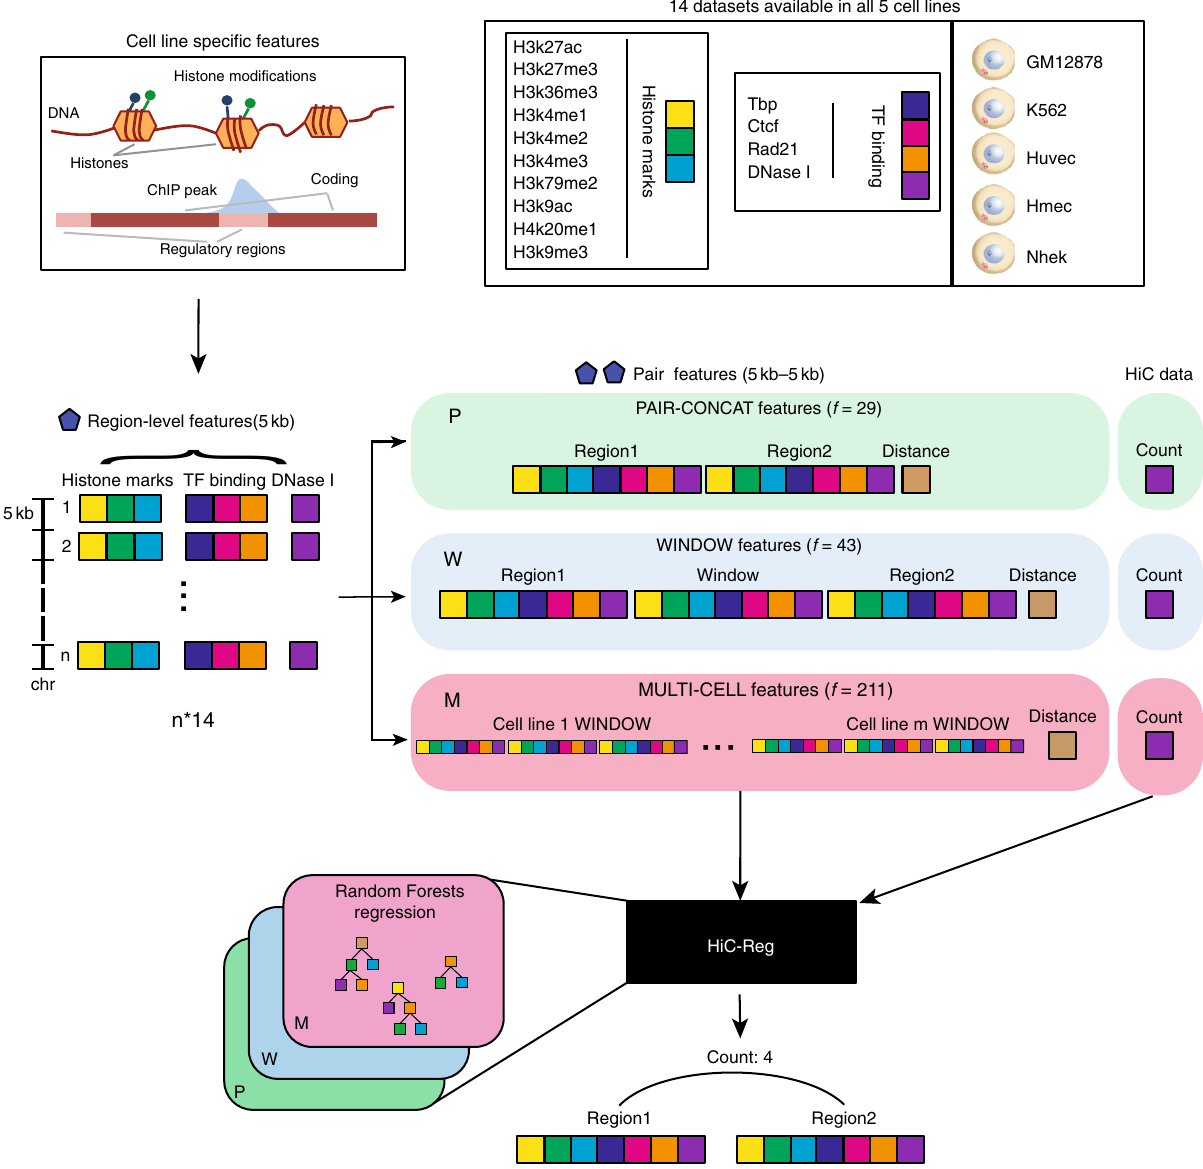
Fig. 1 Overview of the HiC-Reg framework. HiC-Reg makes use of 14 datasets: ten chromatin marks and four datasets related to transcription factor (TF) binding. The TF-binding datasets are factor-speci fi c ChIP-seq datasets and sequence-speci fi c motif counts of a TF in accessible regions. A 5 kb genomic region is represented by a vector of aggregated signals of either chromatin marks, accessibility, or TF occupancy. A pair of regions in HiC-Reg is represented using one of three types of features: PAIR-CONCAT, WINDOW, and MULTI-CELL. HiC-Reg uses Random Forests regression to predict the contact counts between pairs of genomic regions. Once trained, HiC-Reg takes as input a feature vector for a pair of regions and gives as output a predicted contact count for that pair (e.g., Count: